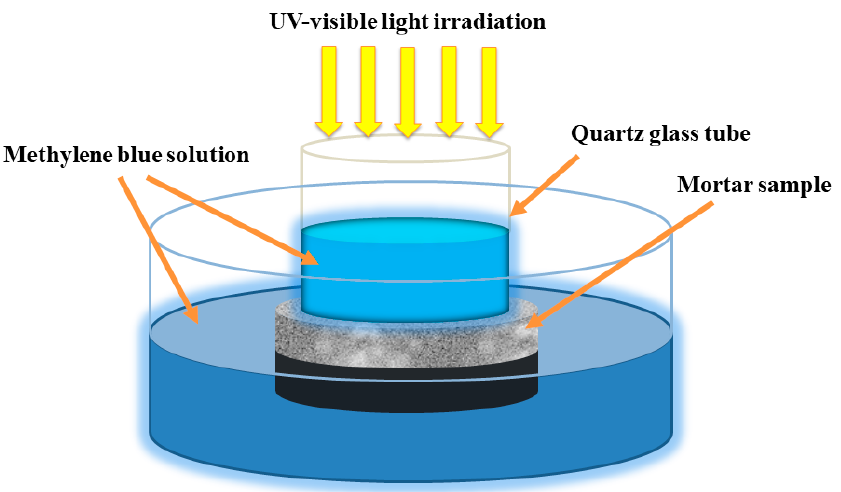
Figure 13. Schematic diagram of MB degradation device.